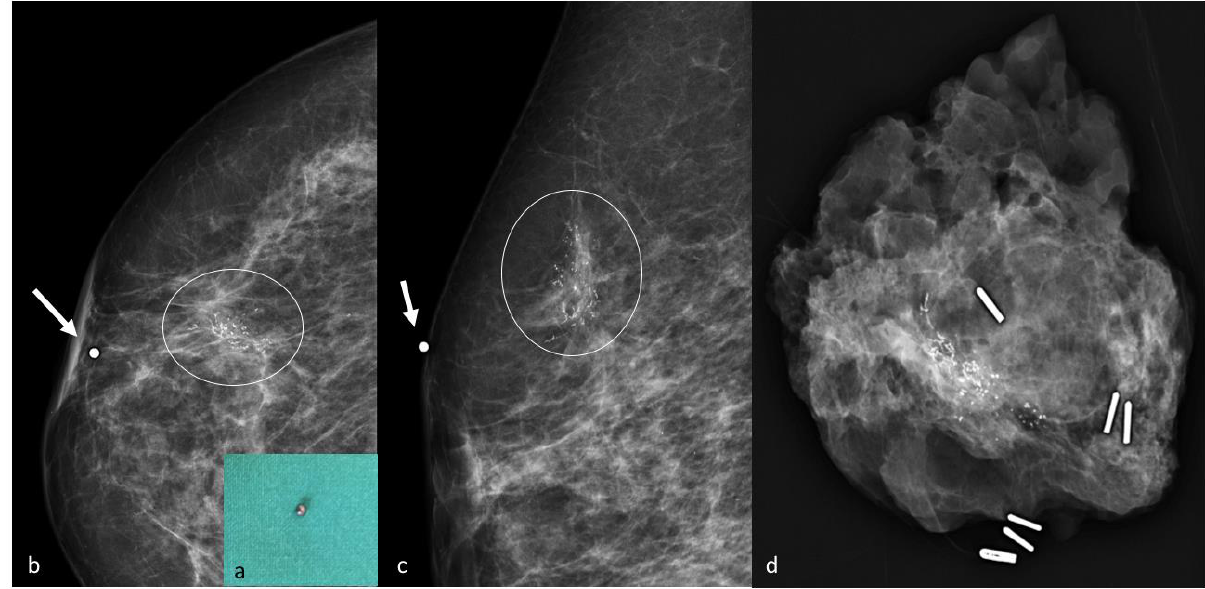
Figure 5. Lead marker positioning during mammographic technique. Metallic marker ( a ). Craniocaudal ( b ) and mediolateral oblique ( c ) views confirm the appropriate marker (arrow) placement on the microcalcifications’ (circle) projection on the skin surface. Specimen X-ray contains the microcalcifications ( d ).